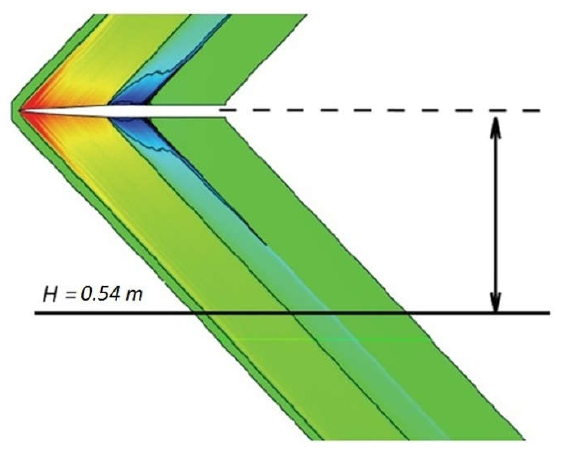
Figure 16. Result estimation scheme. Normalization was performed with respect to pressure Pref (1 atmosphere) from the outer boundary. Curves for calculated results in comparison with experimental results are given in Figure 17.